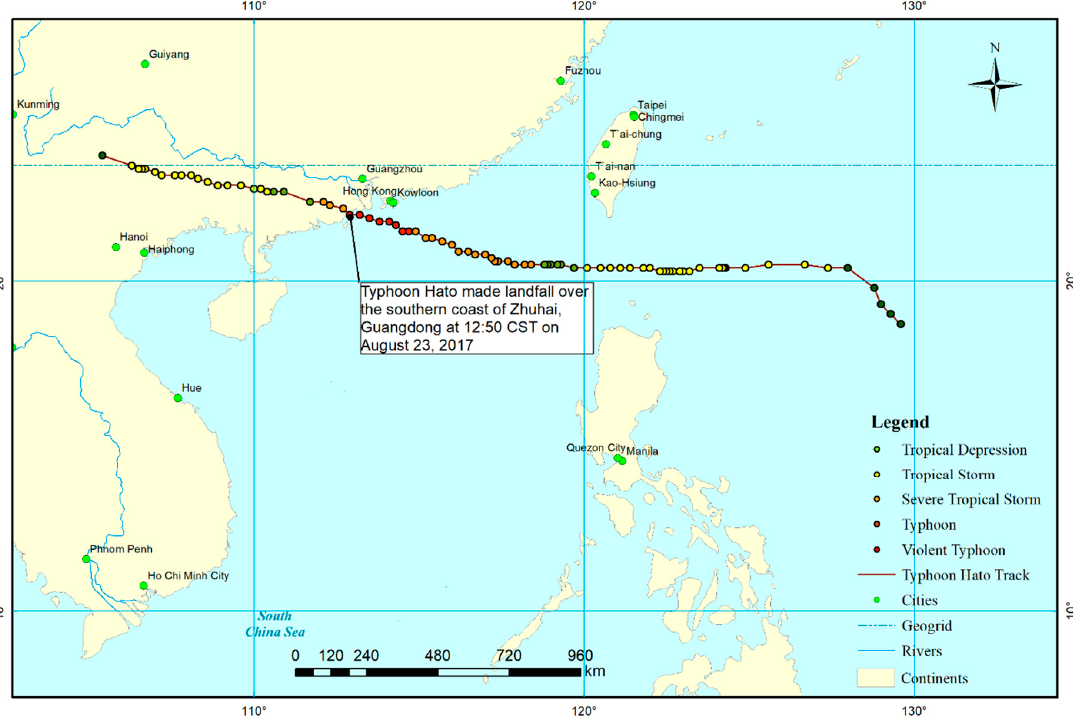
Figure 1. Track of Typhoon Hato.